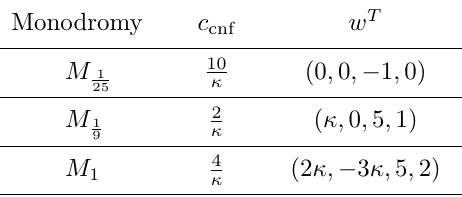
Table 4 . The coe(cid:14)cients and w -vectors for the three conifold points.